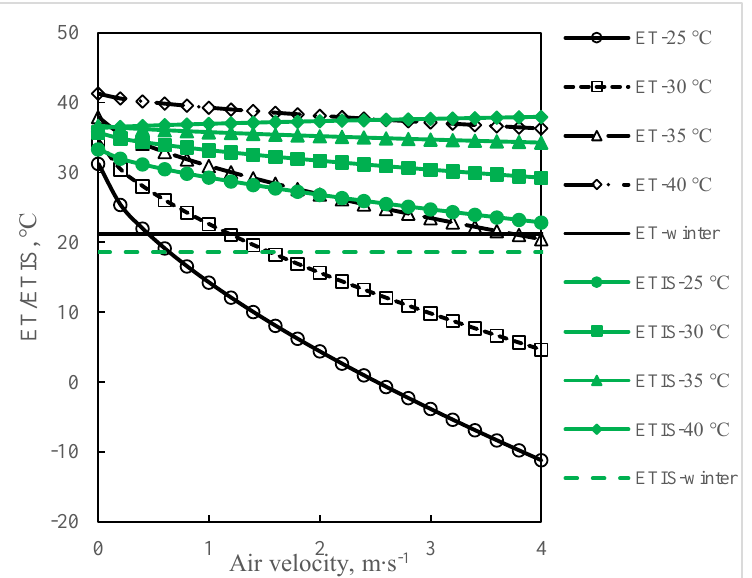
Figure 3. The change of effective temperature or equivalent temperature index of sows with the change of air velocity. When the relative air humidity is 60% and the air temperature is 20 °C, 30 °C, 35 °C, and 40 °C, the air velocity increases from 0 m·s −1 to 4 m·s −1 to analyze the changes in ET and ETIS. ET winter and ETIS winter represent a winter climate with an air temperature of 10 °C, a relative humidity of 60%, and an air velocity of 0 m·s −1 (ET winter = 21.2 °C, ETIS winter = 18.6 °C). With the increase of airflow velocity, a chilling effect will occur, and both ET and ETIS will decrease with the increasing air velocity. When the ET has been applied, there will be interlaces between ET winter and ET of 25 °C, 30 °C, and 35 °C, which does not match the real conditions. In this situation, the ET performs inaccurately predicts the thermal conditions in the sow barn.